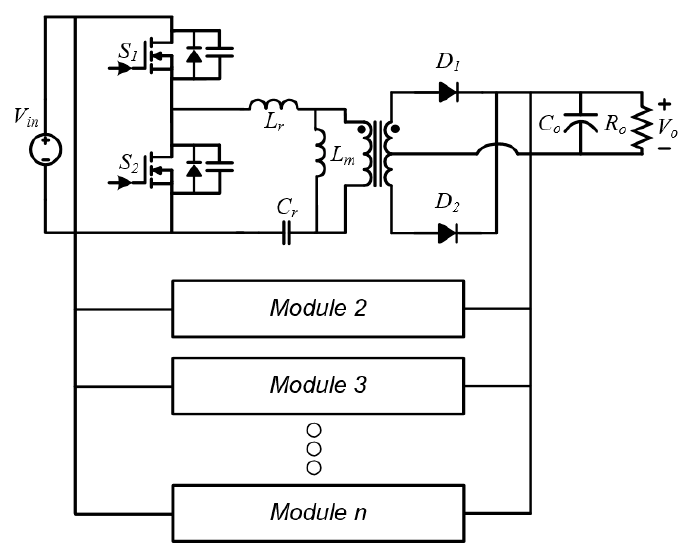
Figure 6. Circuit diagram of parallel connected modular type LLC resonant converter.